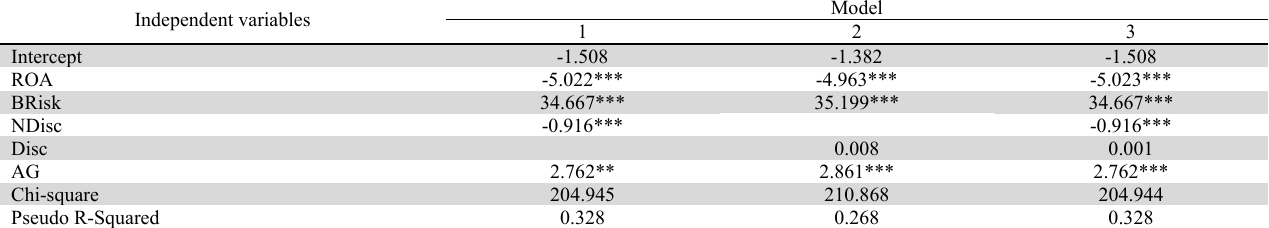
Robustness test: pecking order, earnings management, and capital